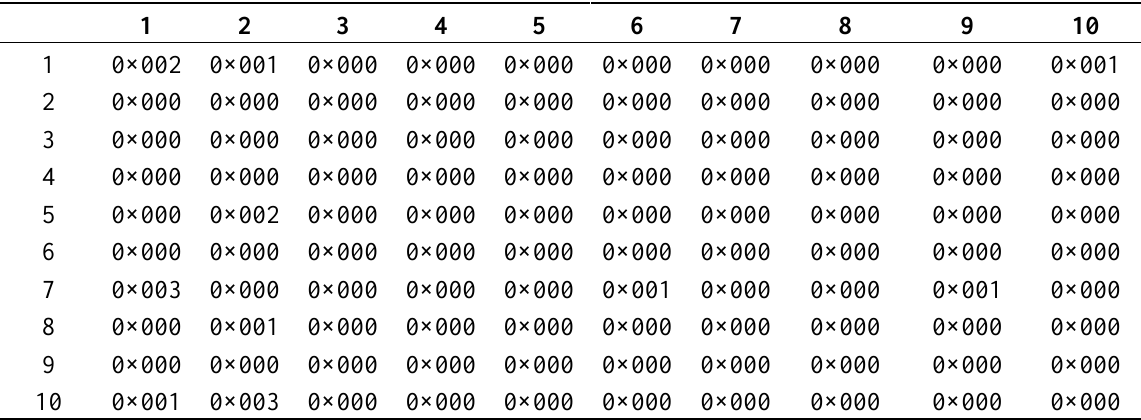
Table 3. Result of signal output in